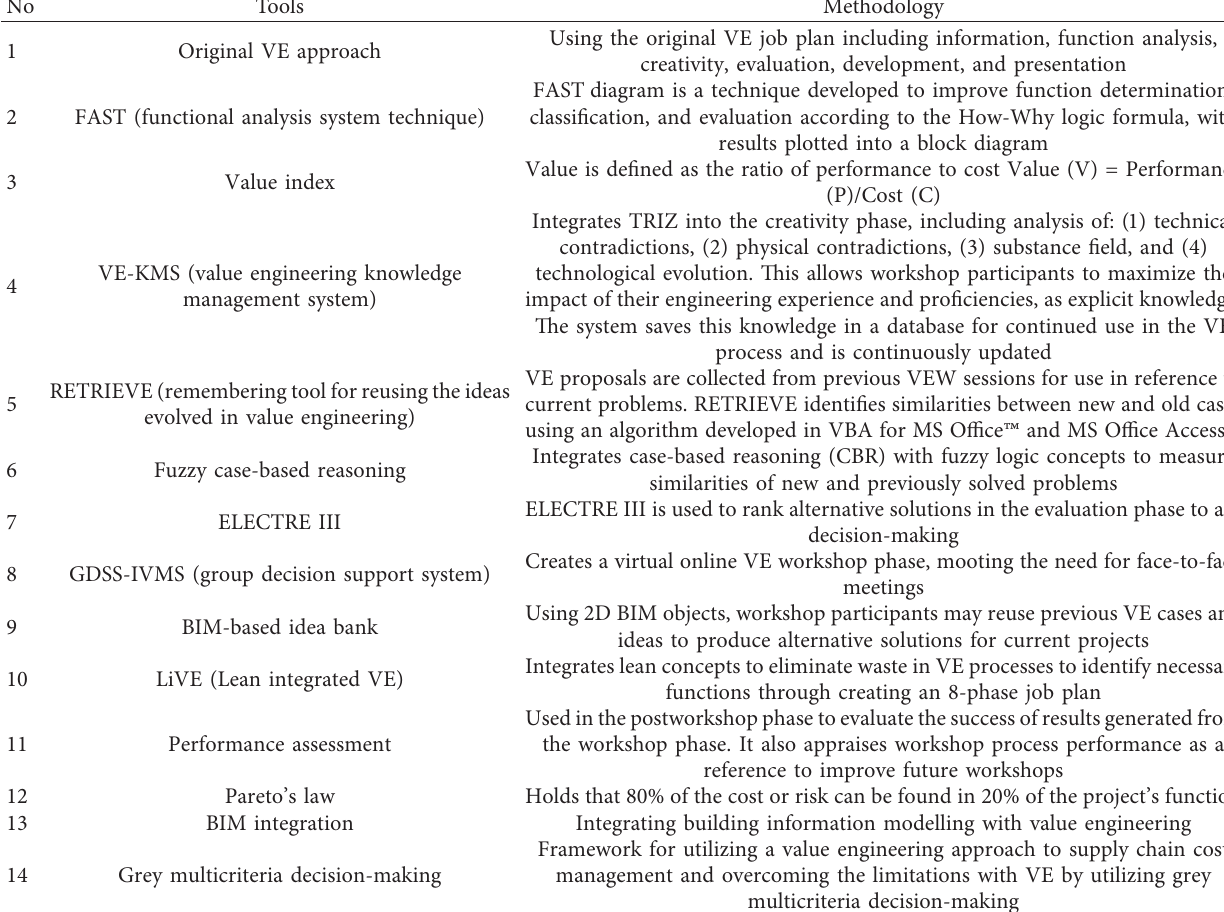
Table 3: VE tools.